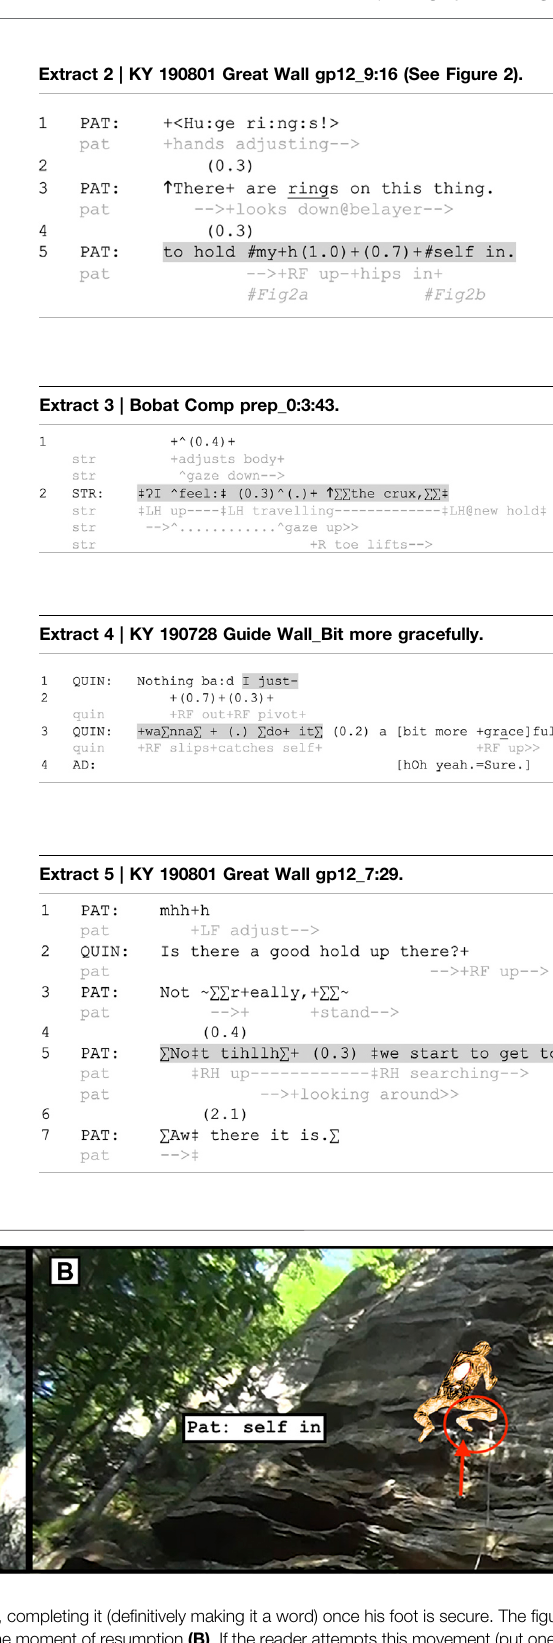
Frontiers in Communication |